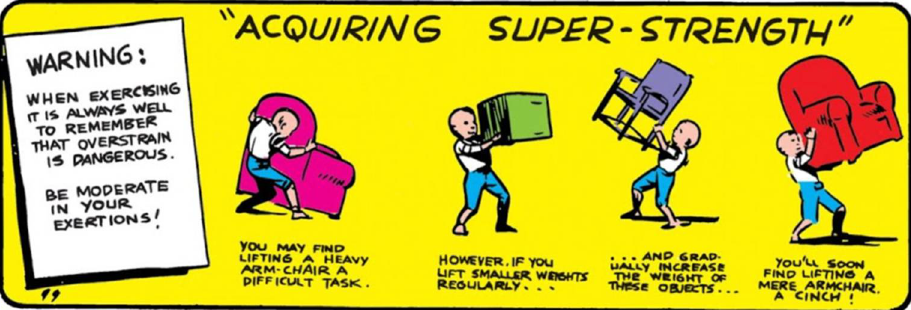
Figure 18. Joe Shuster, Closing Panel: “Acquiring Super-Strength” (panel No. 99), 1938. Siegel and Shuster (September 1938), “Superman”, Action Comics #6 (Siegel and Shuster 1938d, p. 62). © DC Comics.